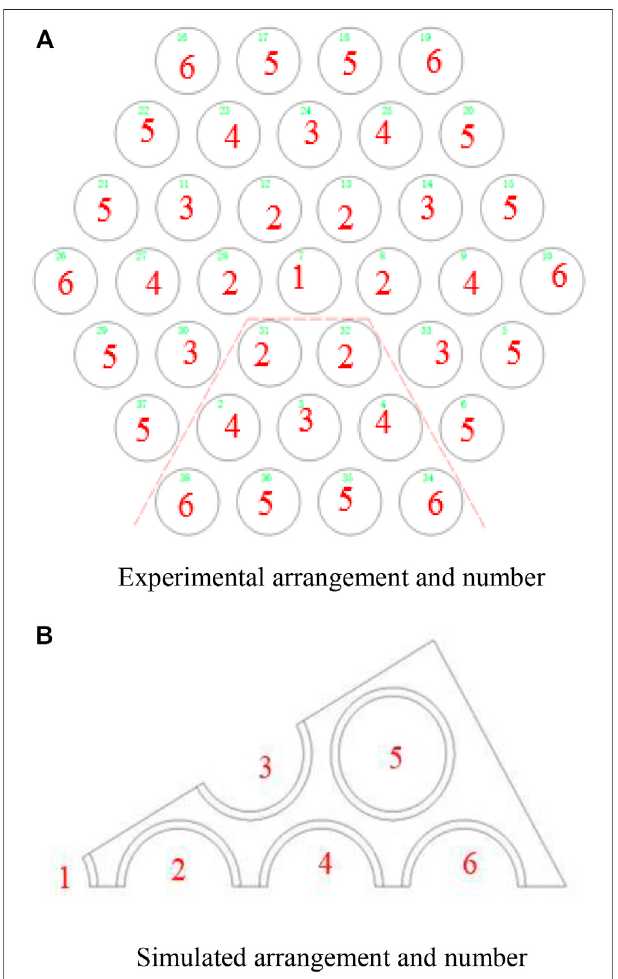
FIGURE 9 | (A) Experimental arrangement and number. (B) Simulated arrangement and number.